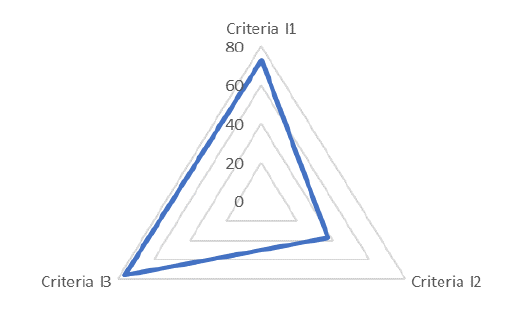
Figure 4. Distribution of inclusion criteria of analysis.